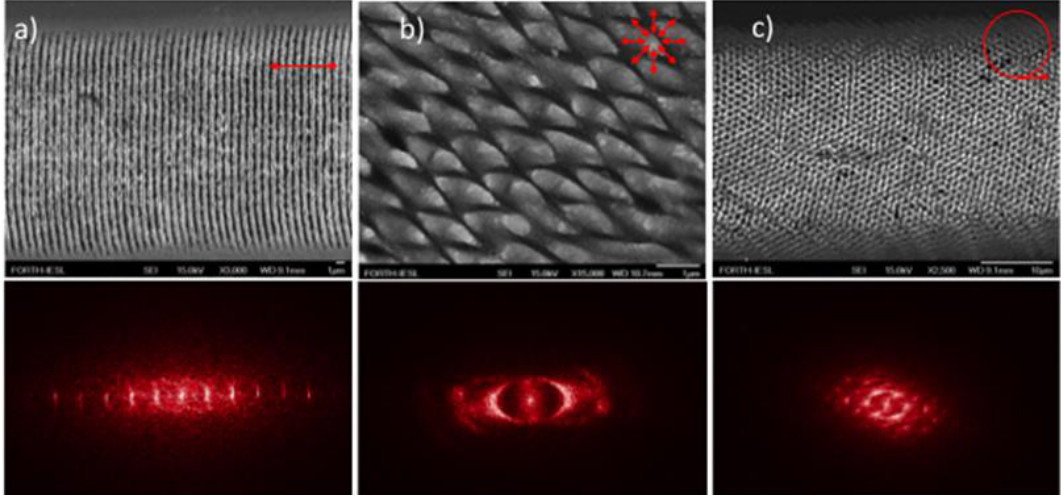
Figure 4. Various LIPSS types formed by FS laser pulses of different polarization: ( a ) Grating-like Laser-induced surface ripples (LISR) formation fabricated with linear polarization; ( b ) rhomboidal multi-directional surface structures produced by radial polarization; and ( c ) columnar structures fabricated by circular polarization. The corresponding fast Fourier transform (FFT) diagrams are also shown, revealing the different spatial frequencies included in each structure [30].